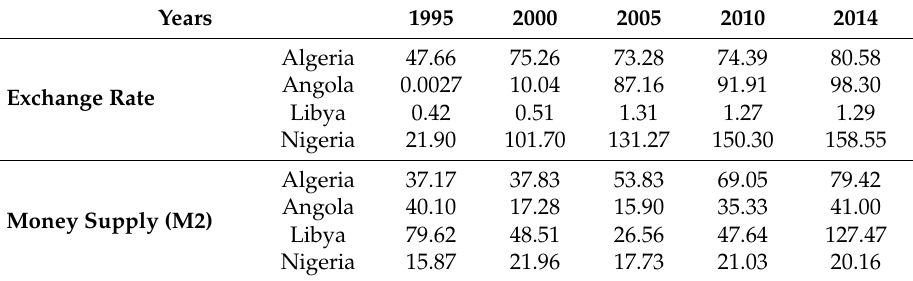
Table 1. African OPEC member countries’ exchange rates and monetary